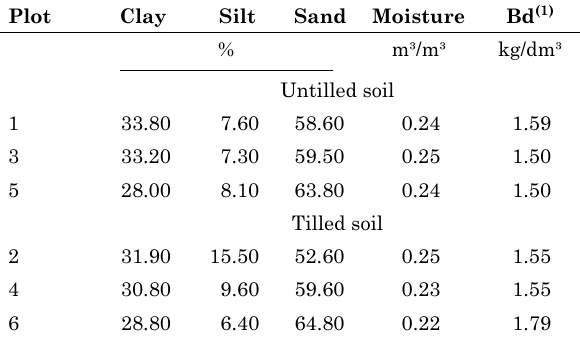
table 1. soil physical characteristics prior to the experiment (surface layer of 10 cm)